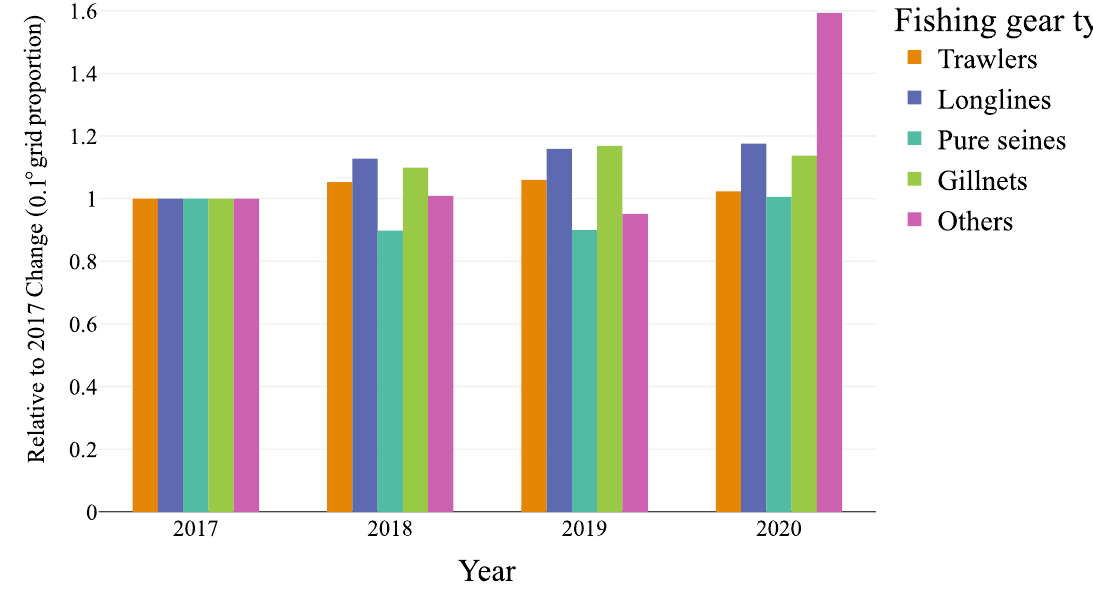
Figure 6. Yearly variation from 2017–2020 of the ratio of global grid counts by fishing gear type relative to 2017. 196